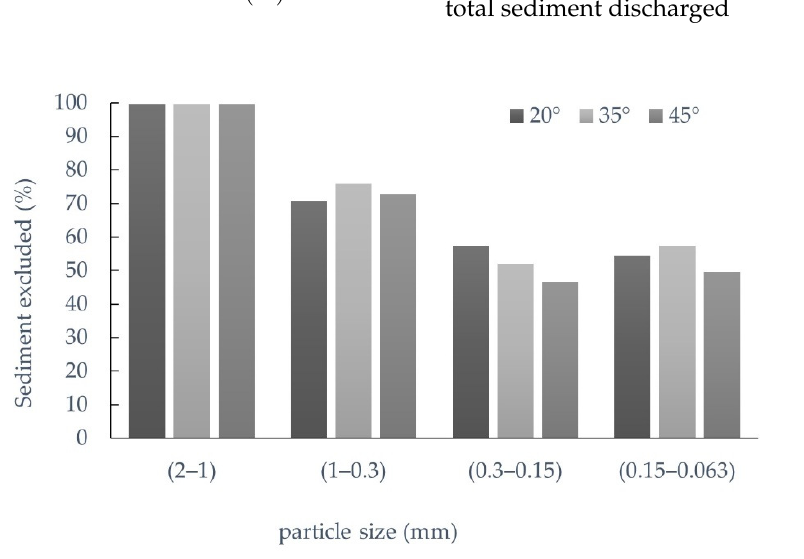
Figure 7. Graph of percentage of the sediment excluded by a triangular wire screen.